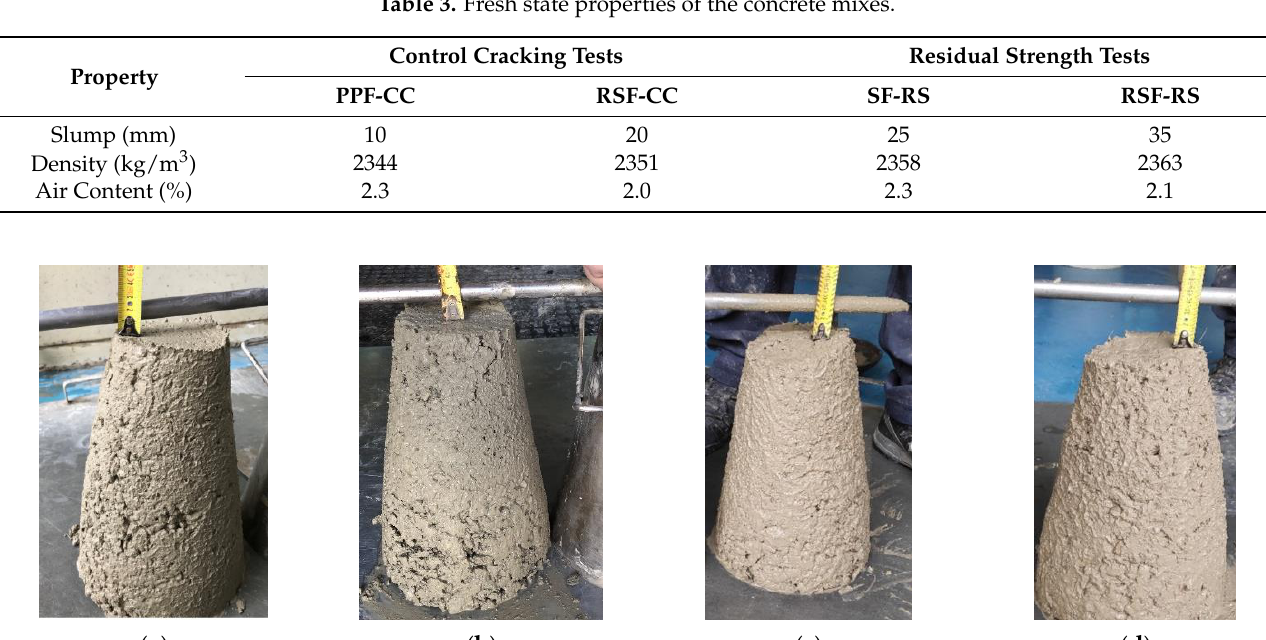
( b ) Figure 8. Histograms of geometrical characteristics: ( a ) Equivalent Fiber Length; ( b ) diameter. 3.2. Fresh State During the mixing of the components, no fiber balls were formed with any type of fiber, including RSF, which could have compromised workability. Table 3 displays a summary of the results obtained in the characterization of the fresh